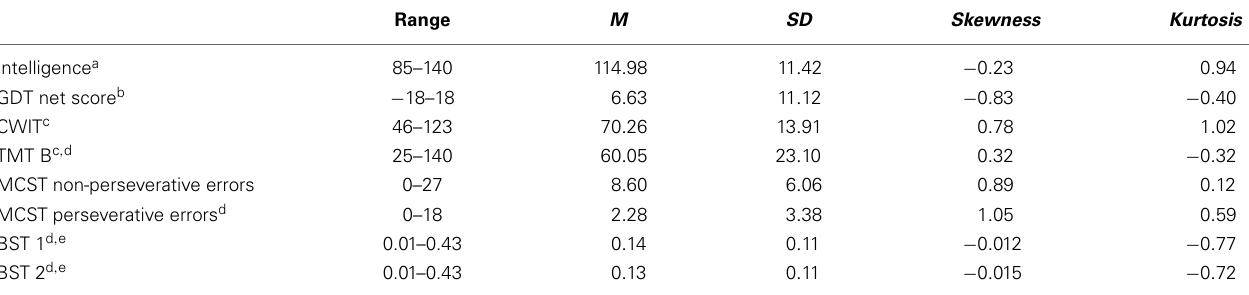
Table 1 | Descriptive values of the sample’s performances in estimated intelligence, GDT, and the executive functioning tests.